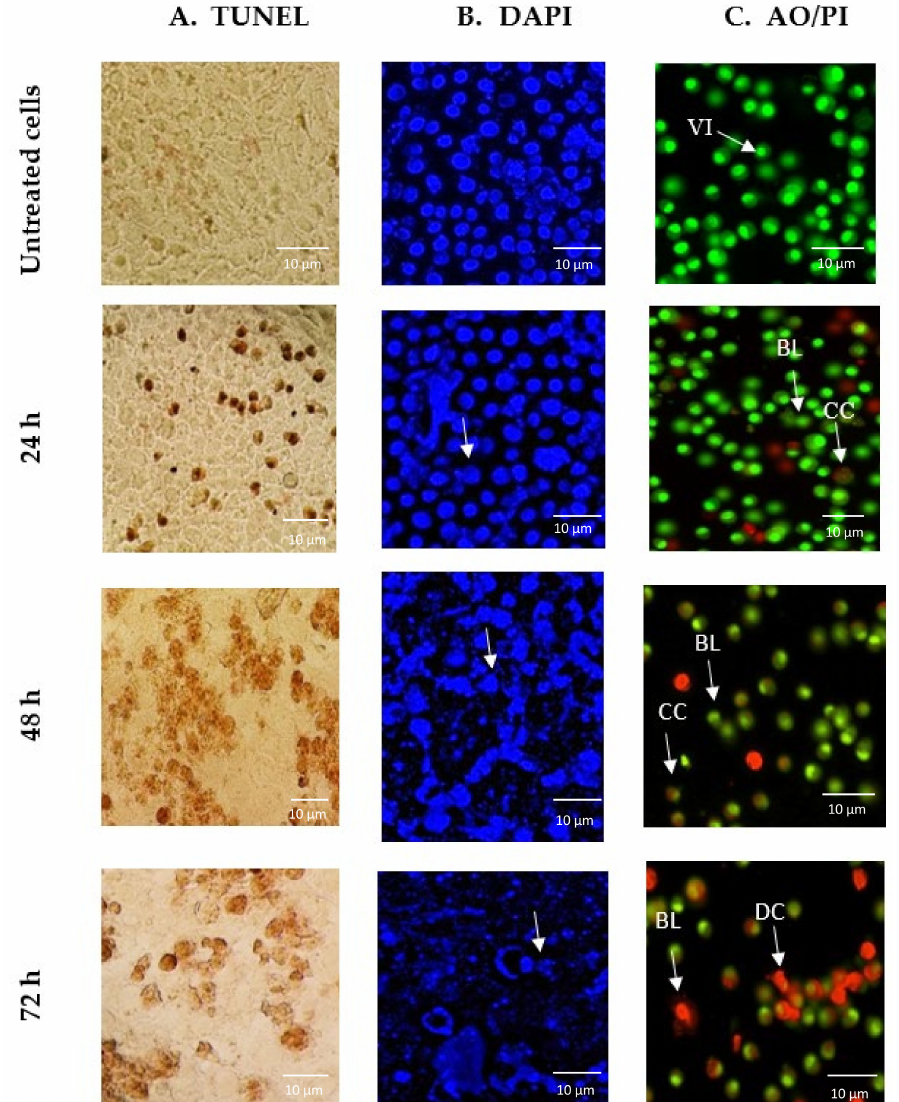
Figure 2. Images of GNST-ITC-induced cell death in HepG2 cells following incubation for 24, 48, and 72 h. ( A ) Micrograph of TUNEL assay under bright field microscopy with darkened stains indicating DNA fragmentation within the cells. ( B ) Alteration in nuclear morphology of GNST-ITC-treated HepG2 cells evaluated using DAPI staining with arrows indicating chromatin condensation in the cell nucleus. ( C ) Fluorescence image of HepG2 cells treated with AO / PI double staining with arrows indicating viable cells (VI), chromatin condensation (CC), membrane blebbing (BL), apoptotic bodies (AB), and dead cells (DC). Results are representative of three independent experiments. Magnification ×